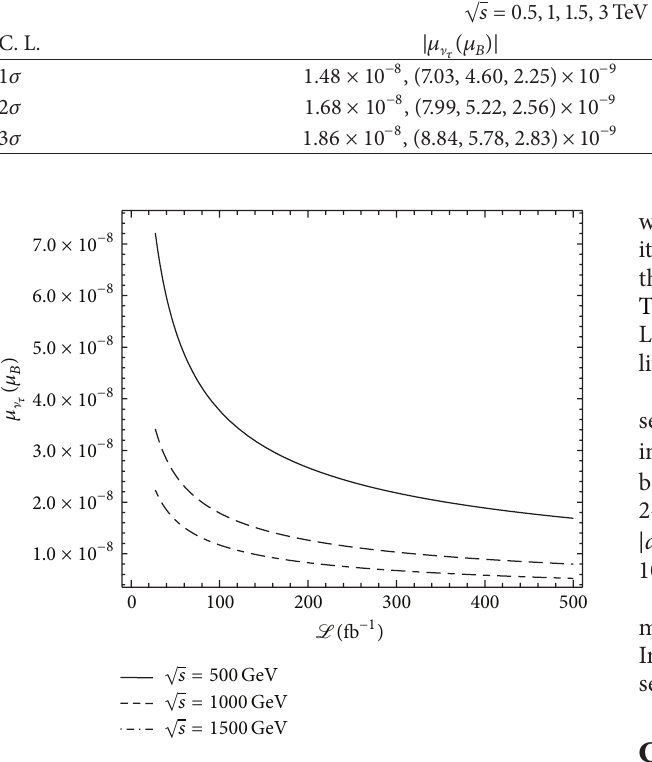
Figure 4: Dependence of the sensitivity limits at 95 % C.L. for the anomalous magnetic moment for three different values of the center of mass energy in the process 𝑒 + 𝑒 − → ]] 𝛾